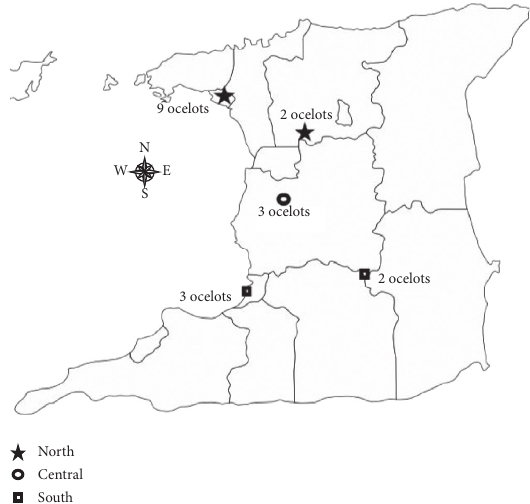
Figure 1: Map of Trinidad displaying the geographic locations of captive ocelots sampled throughout this